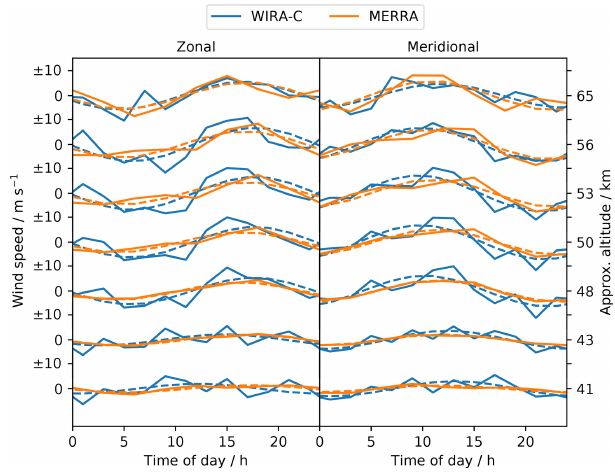
Figure 8. Mean daily cycle of zonal and meridional wind speeds at different altitudes for the 3 months during the arctic campaign from MERRA-2 and WIRA-C. Dashed lines indicate the best fit of the diurnal tide